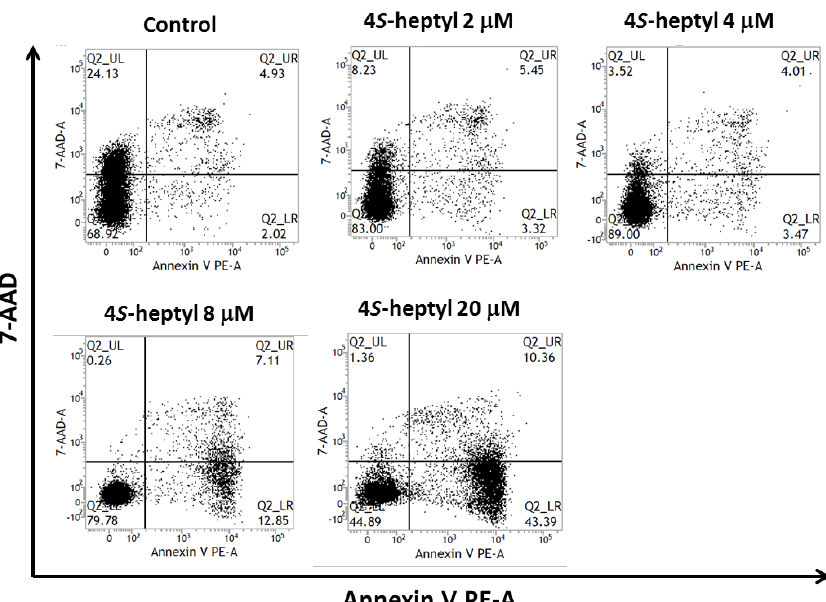
Figure 4. Flow cytometry using HL60 cells treated with 4 S - n -heptyl derivative 9 . Cells were stained with annexin V and 7-AAD before flow cytometry analysis. The percentage of early and late stage apoptotic cells are indicated in Q2_LR and Q2_UR,